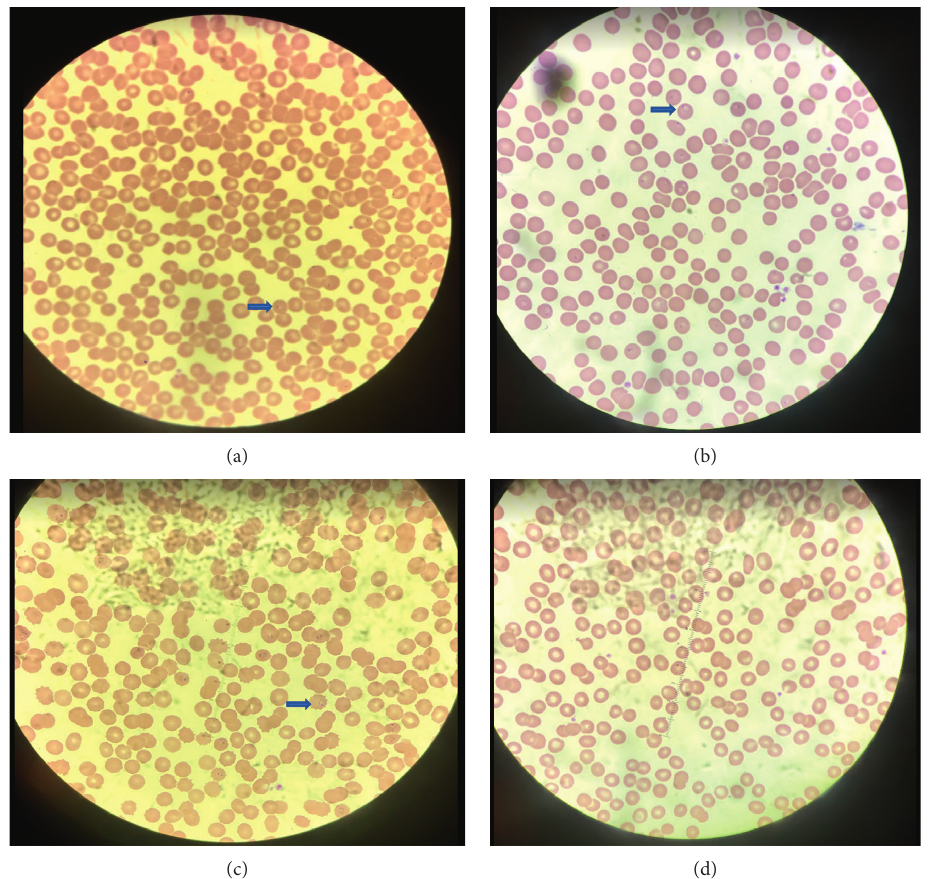
Figure 1: Thin peripheral blood smear: blue arrow showing signet-ring of Plasmodium falciparum in a red blood cell; (a) parasitemia level of 1.6%, (b) parasitemia level of 7.6%, (c) parasitemia level of 12.24%, (d) parasitemia level of